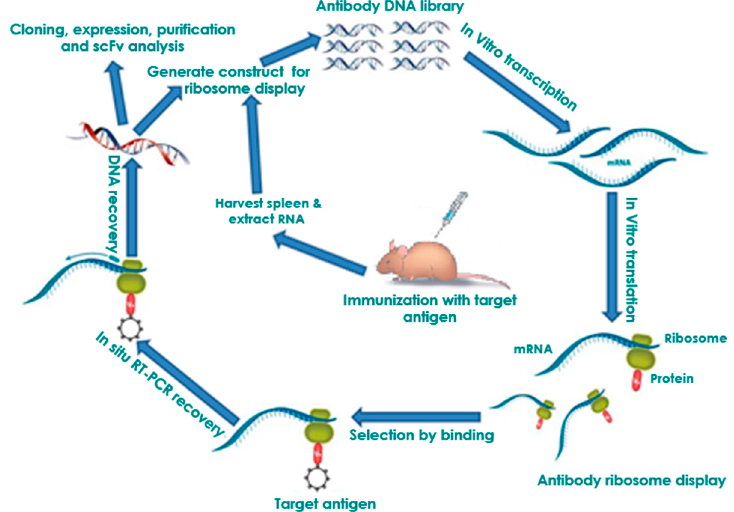
Figure 1. Principle of in vitro ribosome display. DNA library is first amplified by PCR as a T7 promoter, ribosome binding site, the gene, the spacer, and no stop codon. The amplified DNA library is used in an in-vitro coupled transcription / translation to form mRNA, the related protein, and the ribosome complex (PRM complex). The PRM complexes are a ffi nity selected from the transcription / translation mixture by binding of the immobilized antigen. The bound PRM complexes can then be subjected to in-situ RT-PCR to recover the DNA encoding protein sequence and PCR-amplified for an additional selection cycle or postselection analysis.